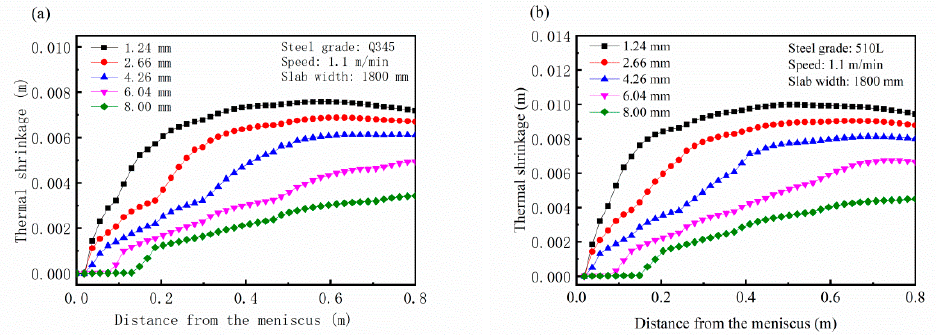
Figure 5. Thermal shrinkage of different thicknesses. ( a ) Q345X; ( b ) 510L